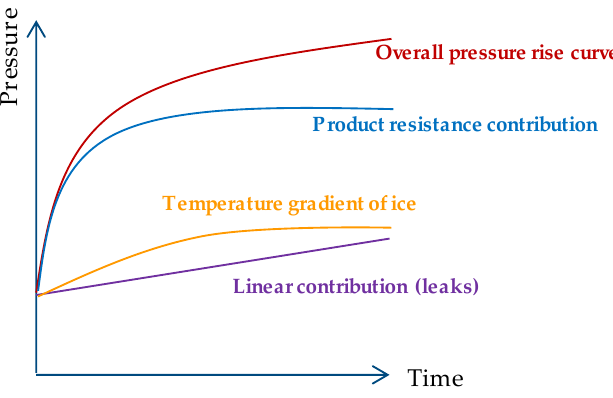
Figure 4. Contributions to pressure rise during MTM.